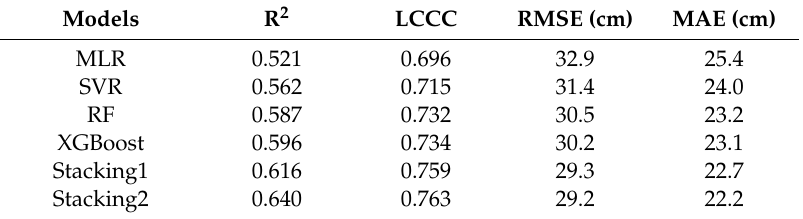
Table 3. Prediction performances of ensemble models for soil thickness using the five best variables.